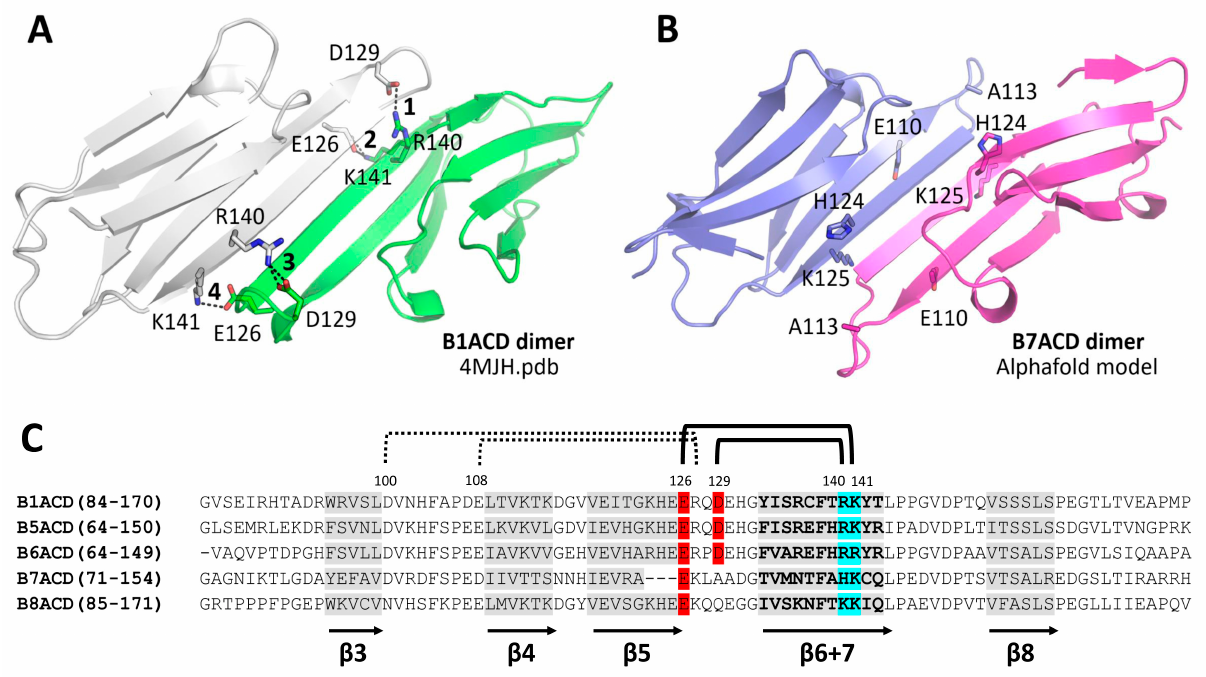
Figure 9. Structural determinants of the different stabilities of the dimeric interfaces of sHsp ACDs. Structural comparison of ( A ) B1ACD and ( B ) B7ACD indicating differences in the numbers of intermolecular salt bridges. The four bridges found in the B1ACD structure are numbered 1–4 and key residues involved in the formation of salt bridges in B1ACD, or equivalent residues in B7ACD, are labeled. ( C ) Alignment of α -crystallin domains of five representative human small heat shock proteins. β -strands are marked in grey and highlighted by arrows. Negatively charged residues that form salt bridges are marked in red and positively charged residues involved in salt bridge formation are marked in blue. Main salt bridges between monomers are indicated by solid brackets and auxiliary contacts are indicated by dashed brackets. Numbering above alignment corresponds to HspB1. For multiple alignments generated by T-Coffee [35] (Available online: